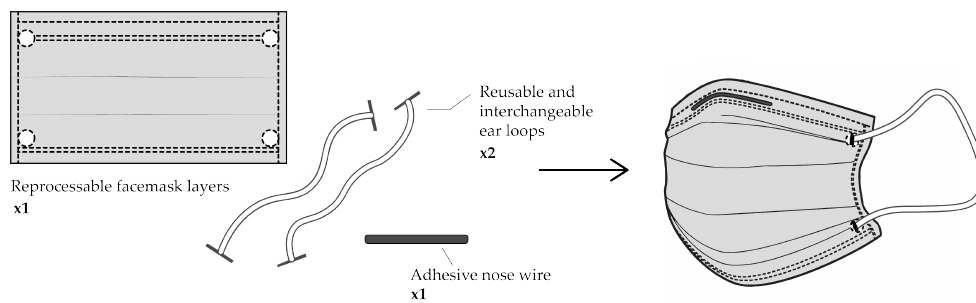
Figure 13. Schematic representation of the PET-based surgical mask